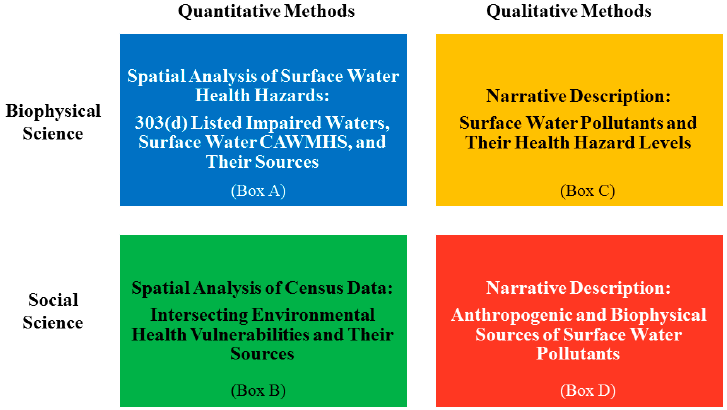
Figure 2. The critical physical geography “methodological four-square” [51] adapted to the present study’s examination of impaired water hazard zones and the sociospatial dimensions of water injustice in the Bay-Delta. CAWMHS, cumulative areal-weighted modeled hazard